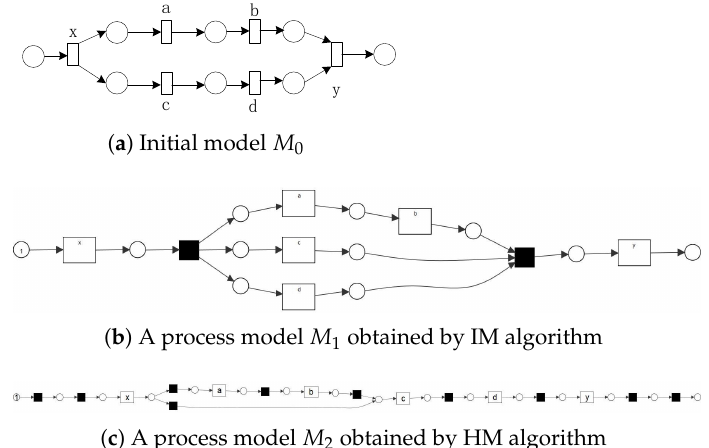
Figure 4. Process mining results of incomplete logs caused by high